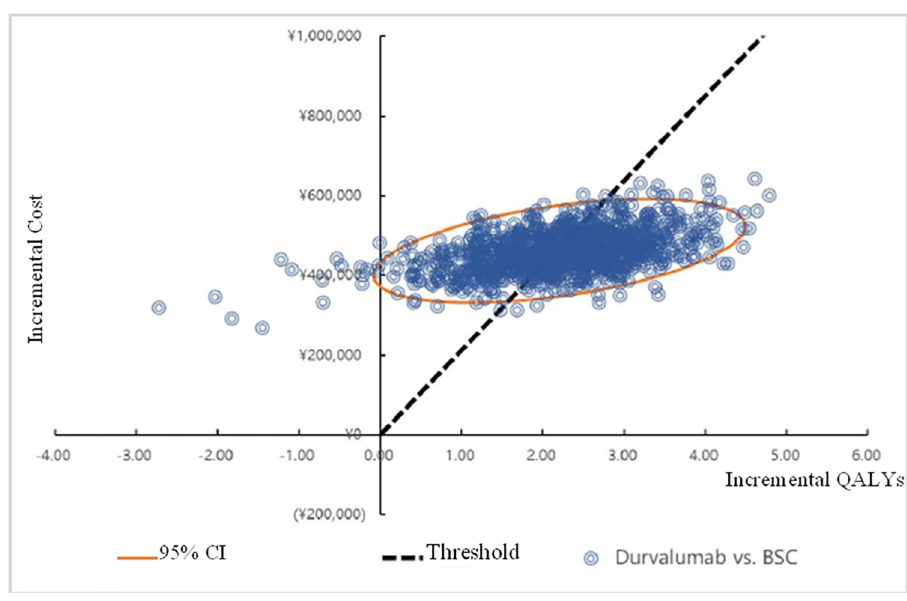
Fig 3. Cost-effectiveness plane scatter plot.